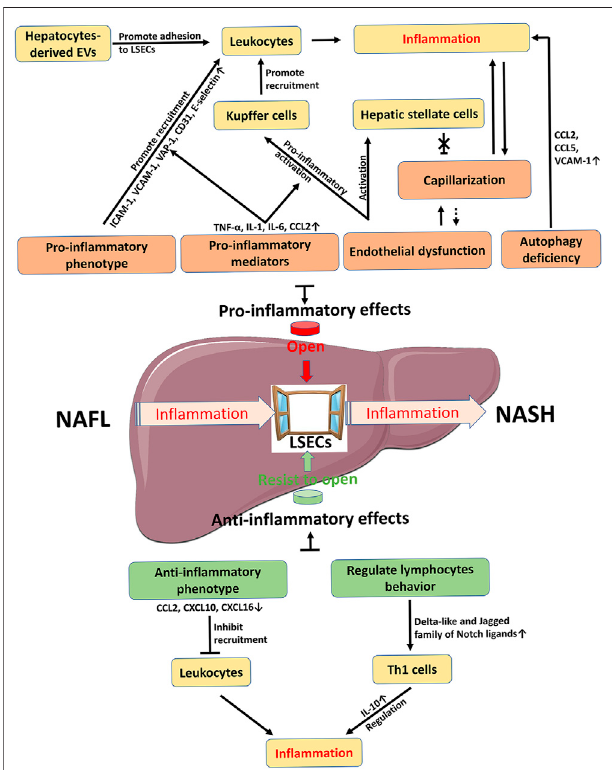
FIGURE 4 | Schematic summary on the role of LSECs in NAFLD in fl ammation. In fl ammation is a key factor in the development of NAFL to NASH. LSEC as a window controls the occurrence and progression of in fl ammation. The pro-in fl ammatory effect of LSECs promotes the openingofthewindow, while the anti-in fl ammatoryeffect ofLSECs acts asan opponent to prevent the passage of in fl ammation. Therefore, how to control the window provides new strategies for the R&D of novelty drugs against NAFLD/NASH. The dotted line is a possible relationship. CCL C-C motif chemokine ligand, CXCL C-X-C motif chemokine ligand, EVs extracellular vesicles, ICAM-1 intercellular adhesion molecule-1, IL interleukin, LSECs liver sinusoidal endothelial cells, NAFL, nonalcoholic fatty liver, NASH nonalcoholic steatohepatitis, TNF- α tumor necrosis factor- α , VAP-1 vascular adhesion protein-1, VCAM-1 vascular cell adhesion